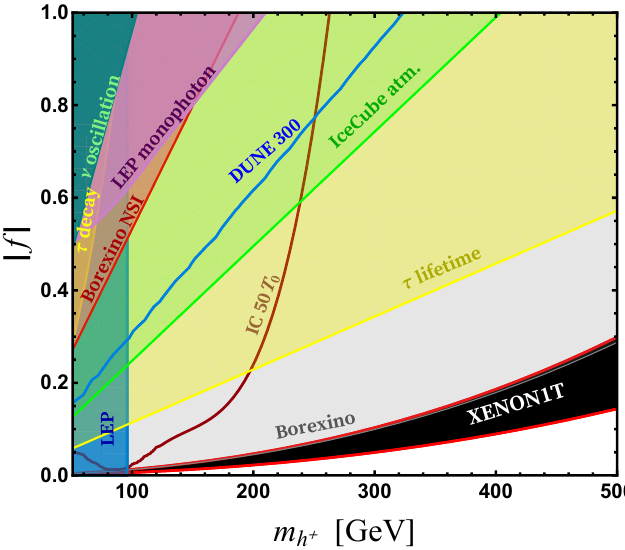
Figure 13 . Allowed parameter space of the SU(2) H model. The region labelled XENON1T explains the electron recoil excess at 90% C.L. . The blue-shaded region is excluded by LEP searches of charged scalar; purple-shaded region indicates exclusion from LEP monophoton search; light yellow-shaded region is excluded from (cid:28) lifetime bound and the dark yellow region is excluded from (cid:28) decay asymmetry constraints. We show the direct constraints on NSI from the global (cid:12)t to neutrino oscillation + COHERENT data [71] (dark-green shaded region), neutrino-electron scattering experiments such as Borexino [72] (orange shaded region) and IceCube atmospheric neutrino data [73] (light-green shaded region). The blue solid line indicates the future DUNE sensitivity for 300 kt.MW.yr exposure [74]. The future IceCube sensitivity is shown by solid brown curve, for an exposure times (50 (cid:2) the current exposure T 0 = 2653 days). The gray shaded region indicates the current exclusion limit on neutrino magnetic moment from Borexino experiment. Here we set m = m + 500 GeV and f 0 H + h +